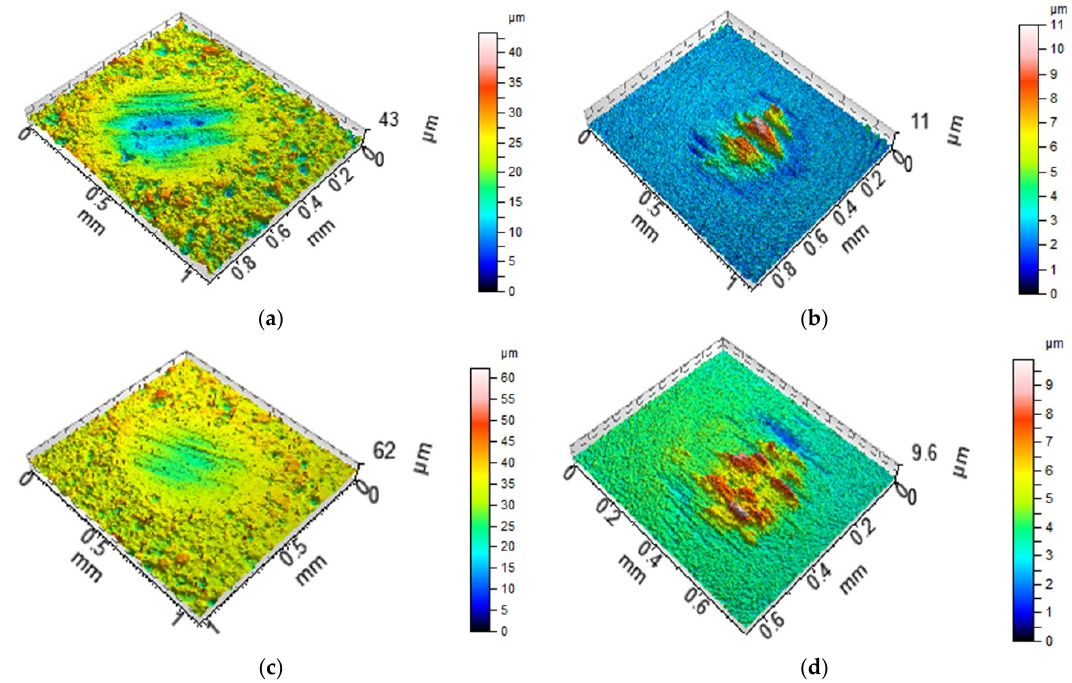
Figure 15. Isometric views of disc VB1 ( a , c ) and co-acted balls ( b , d ) after tests C ( a , b ) and D ( c , d ).